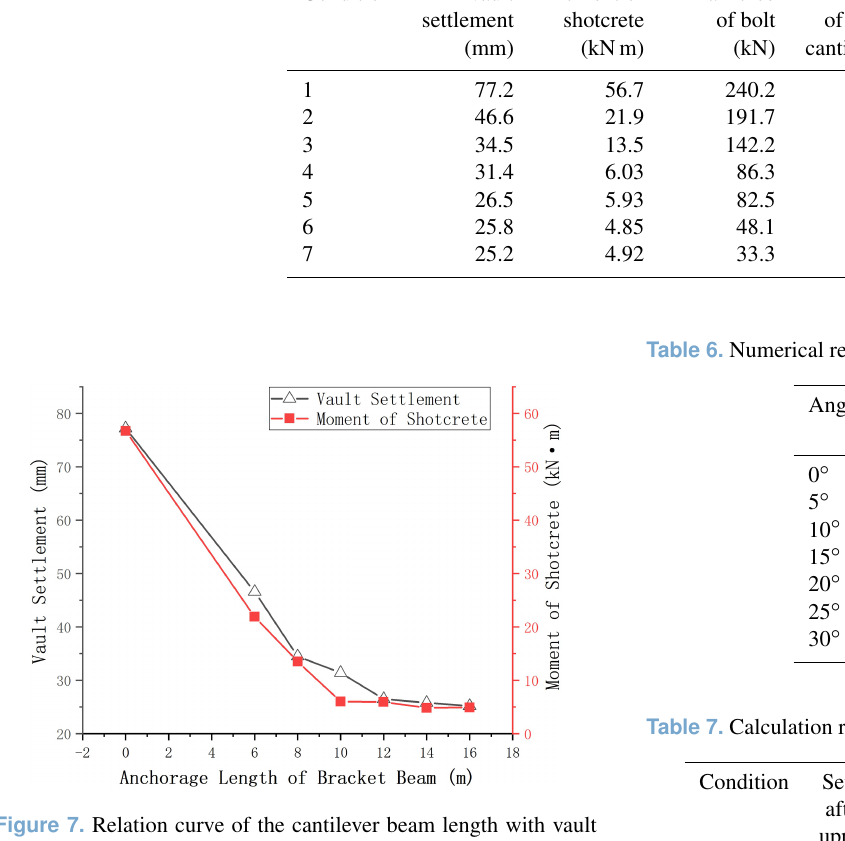
Figure 7. Relation curve of the cantilever beam length with vault settlement and moment of shotcrete.